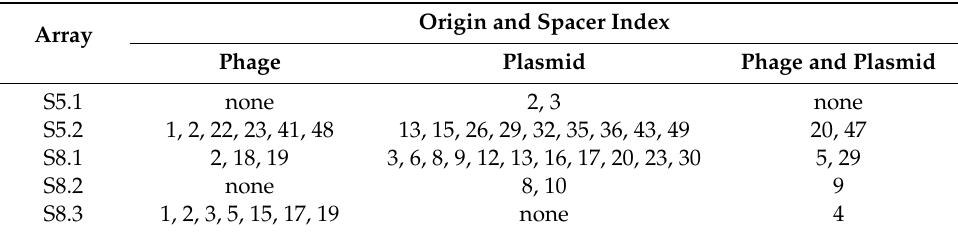
Table 2. Origin of spacers found in CRISPR-Cas systems of S. marcescens strains S5 and S8.